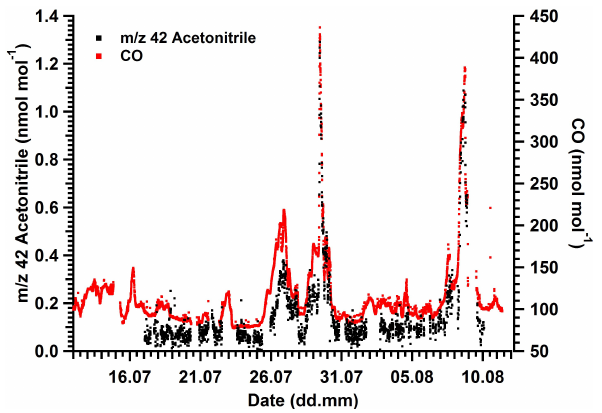
Fig. 9. The mixing ratios of SO 2 and n-pentane are plotted for the duration of the HUMPPA-COPEC campaign (plus two days). Mea- surements taken from the main mast at